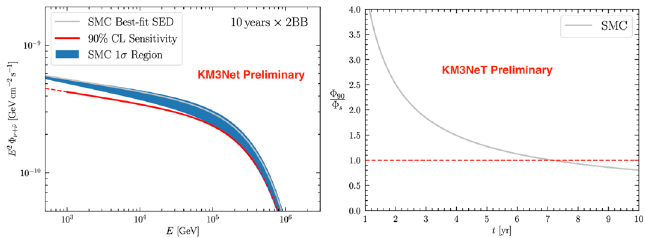
Figure 2. Left sensitivity compared with the theoretical 1 σ uncertainty band of the source (according to the analysis of [3]). Right Sensitivity as a function of time. The detector will be able to put strict constraints after 7 years of data taking.